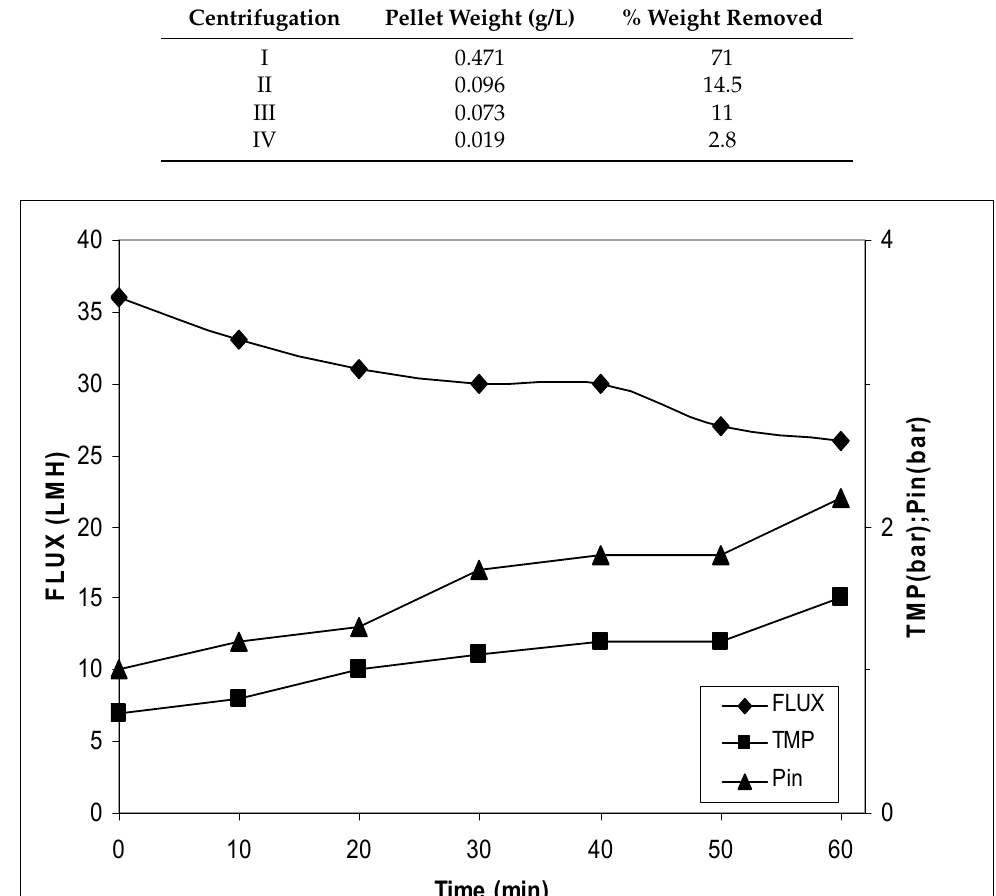
Figure 5. Transmembrane flux, corresponding TMP, and inlet pressure during the ultrafiltration treatment. The experiments were performed in triplicate.